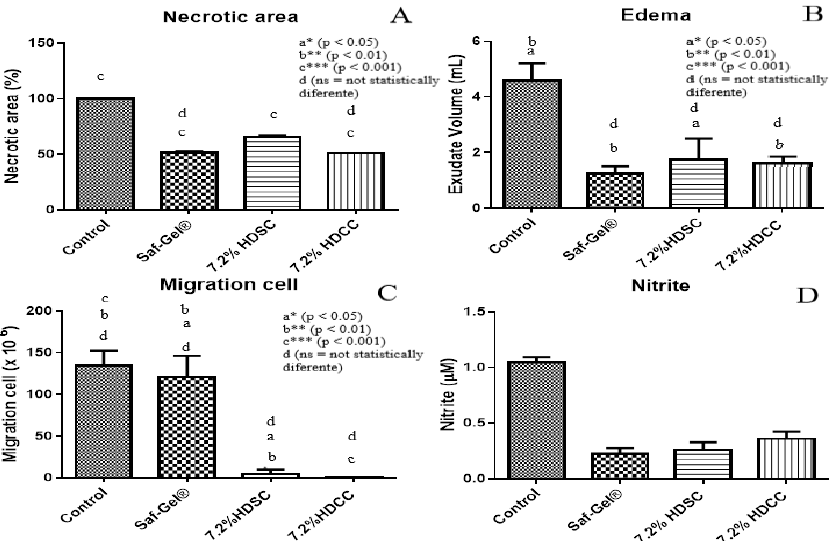
Figure 6. The effect of different samples of wound healing in ischemia-reperfusion model. ( A ) Necrotic area, ( B ) Edema, ( C ) Migration cell and ( D ) Nitrite. The p -value was compared between groups was admitted to be statistically significant when p < 0.05. Different letters in the same column indicate significant difference: a * ( p < 0.05), b ** ( p < 0.01), c *** ( p < 0.001) d (ns = not statistically different).